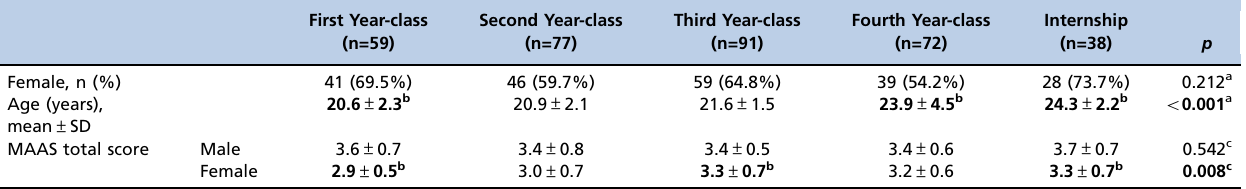
Table 3 - Analysis of Mindful Attention Awareness Scale (MAAS) of each year-class